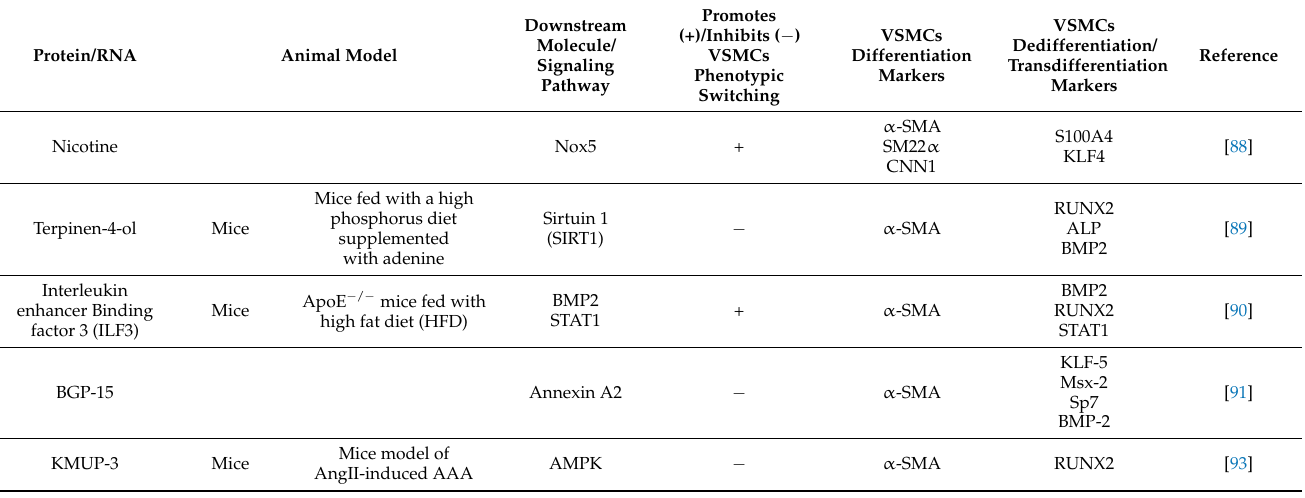
Table 4. Molecular mechanisms of VSMCs phenotypic switching in Vascular calcification.